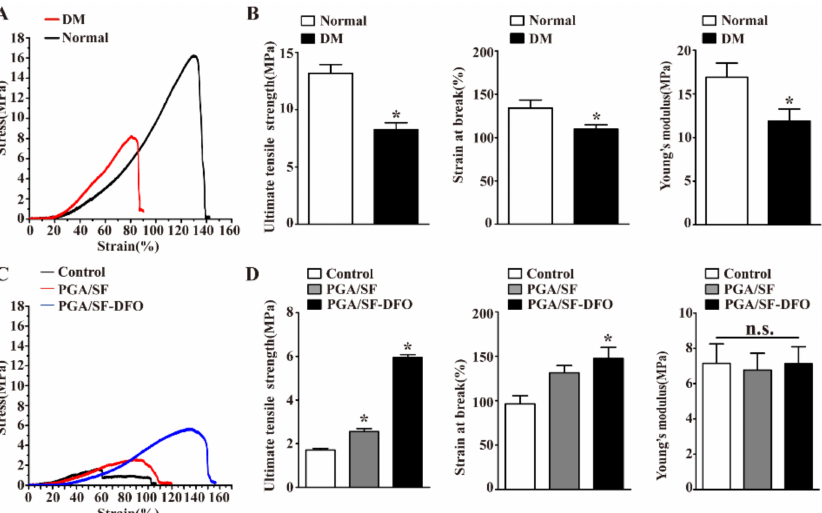
Figure 10. Mechanical properties of the skin/wound beds. ( A ) The stress–strain curves of skin from normal and diabetic mice (DM). ( B ) Ultimate tensile strength, strain at break, and Young’s modulus of skin from normal and diabetic mice (DM). Asterisks (*) indicate statistical significance, ( p < 0.05). ( C ) The stress–strain curves of wound bed from control, PGA/SF, PGA/SF-DFO group at day 14 post-implantation. ( D ) Ultimate tensile strength, strain at break, and Young’s modulus of skin from control, PGA/SF, PGA/SF-DFO group at day 14 post-implantation. Asterisks (*) indicate statistical significance, ( p < 0.05), and n.s. represents no significant